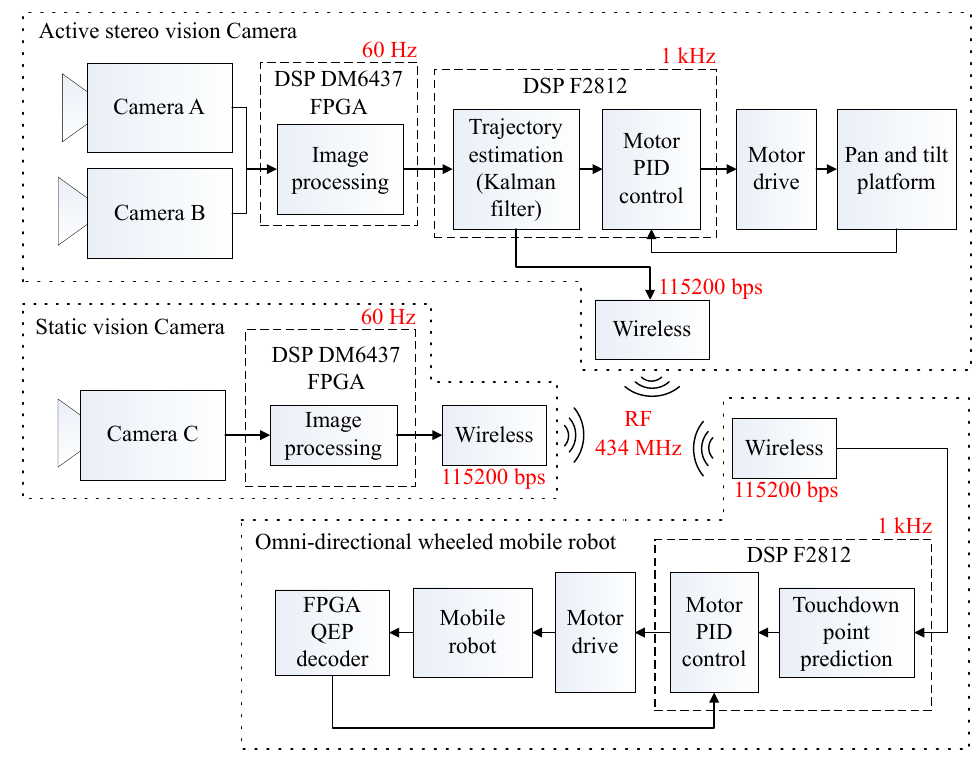
Figure 9. Block diagram of the proposed